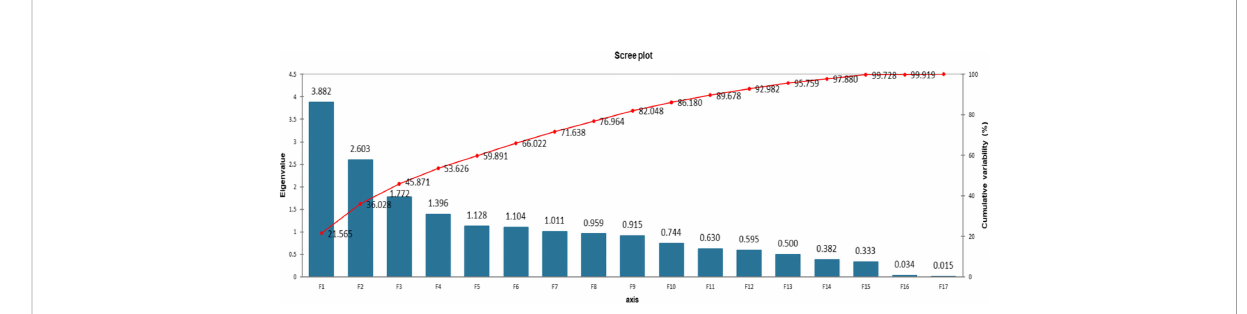
FIGURE 8 Scree plot (A) representing eigenvalue and cumulative variability for parameter under